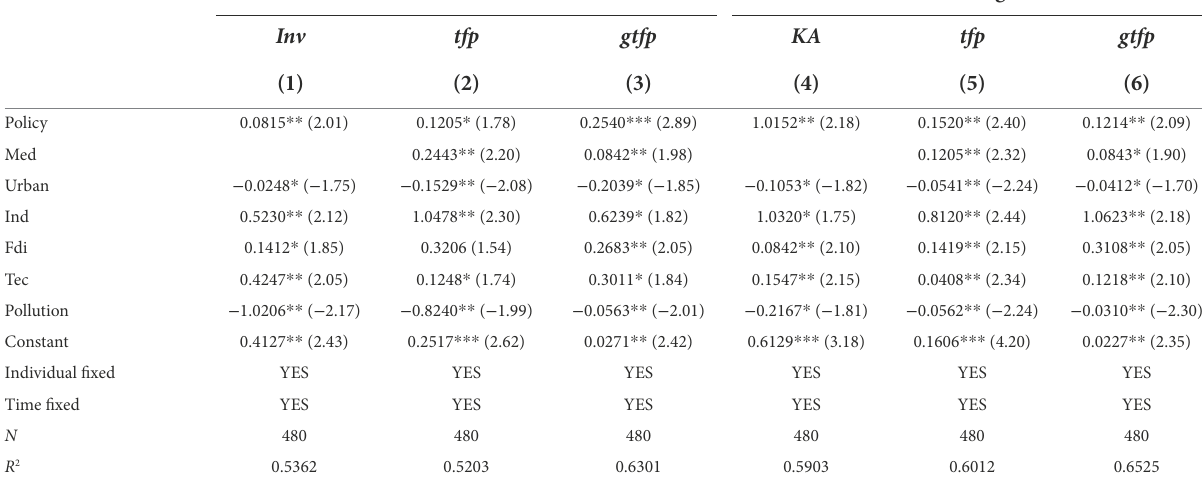
TABLE 6 Results of the impact mechanism test (1).